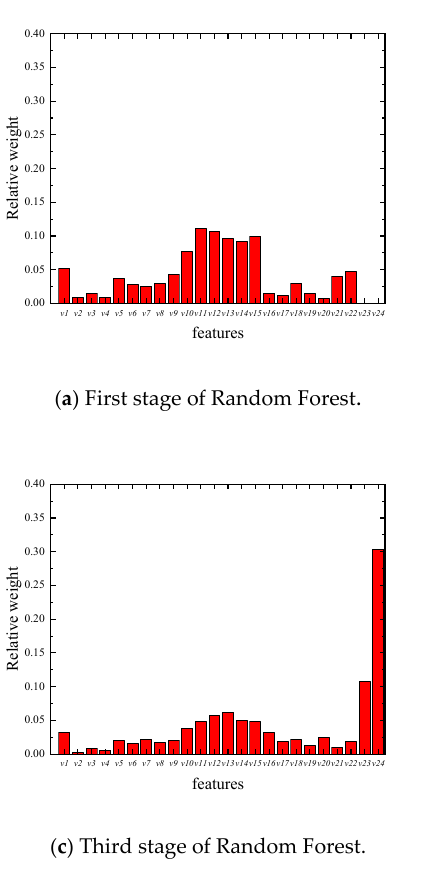
Table 3. Crack detection results (cross-validation).